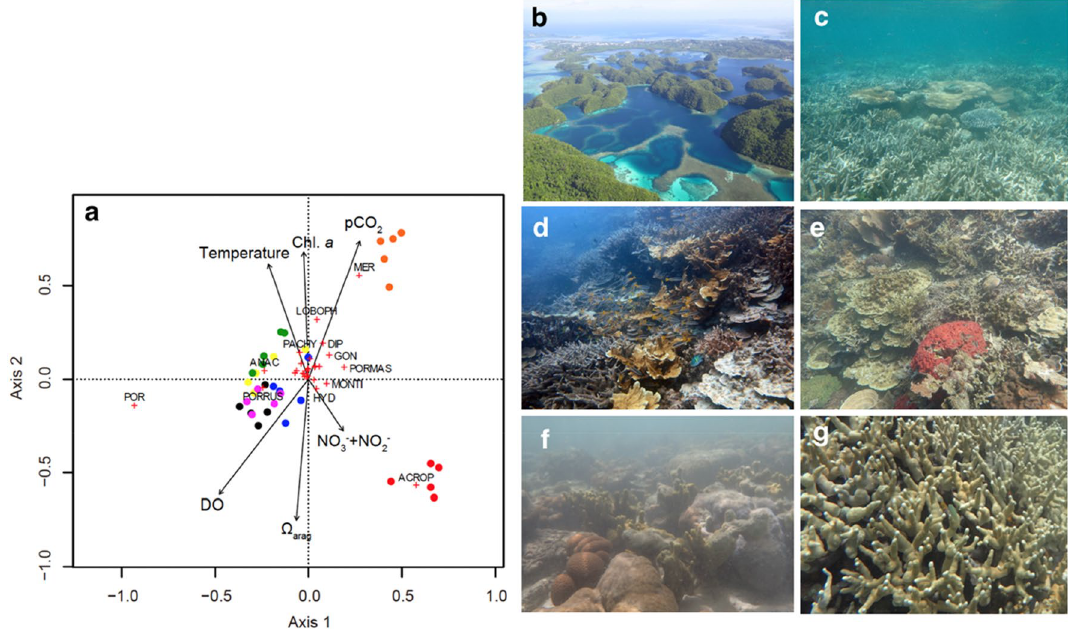
Figure 4. Redundancy analysis (RDA) for water quality and hard coral community at seven sites around Nikko Bay (N1-N7) and image of sites with different benthic communities. ( a ) Ordination of coral community based on redundancy analysis (Eigenvalue axis 1: 0.1795, Eigenvalue axis 2: 0.1035). Arrows represent significant seawater environmental variables, and their direction and length indicate their contributions to variation along those axes. Dots indicate transect lines with colors distinguishing study sites: red: N1, black: N2, blue: N3, yellow: N4, light blue: N5, green: N6, pink: N7. Genera/families of hard corals are indicated by plus symbols; selected genera are indicated by codes: LOBOPH: Lobophyllia spp., ACROP: Acropora spp., ANAC: Anacropora spp., MONTI: Montipora spp., MER: Merulinidae, DIP: Dipsastrea spp., GON: Goniastrea spp., HYD: Hydnophora spp., PACHY: Pachyseris spp., POR: branching Porites spp., PORMAS: massive Porites spp., PORRUS: Porites rus . ( b ) aerial image of Nikko Bay, ( c ) image of site N1 (Ω arag = 3.51), a reef outside of